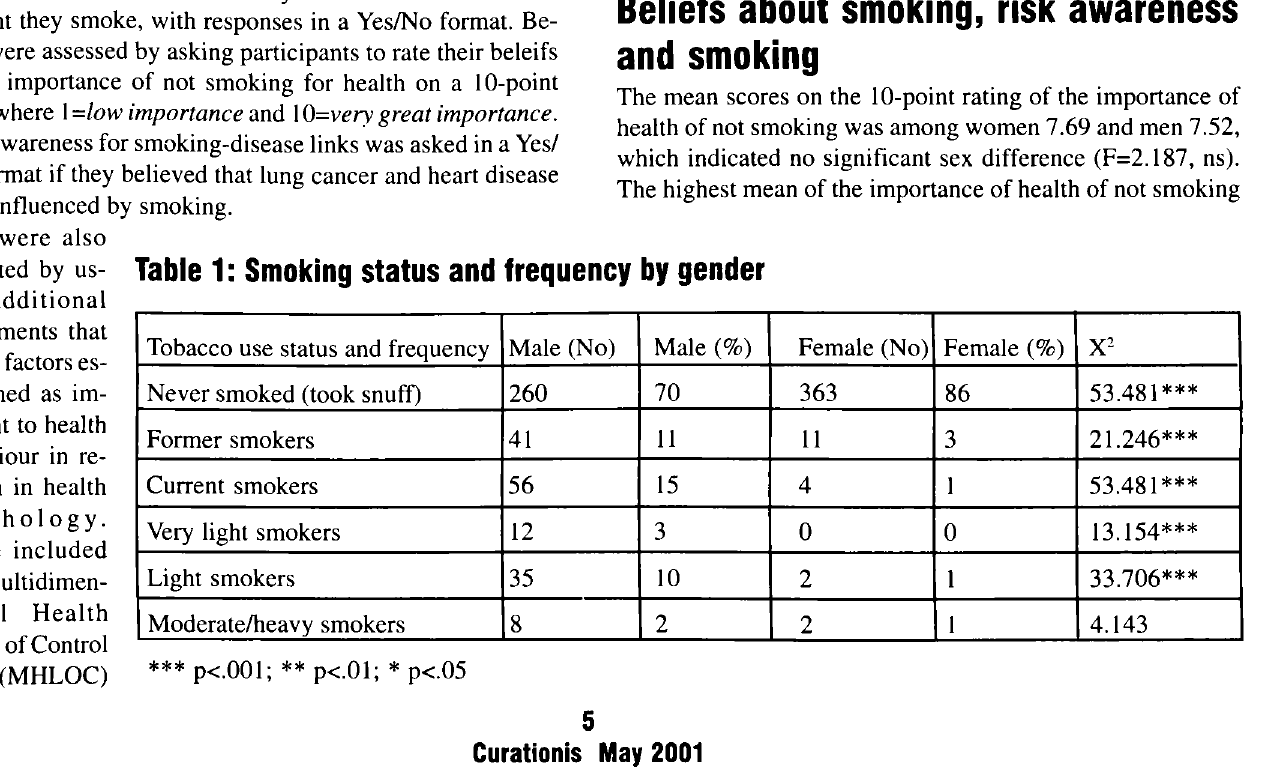
Table 1 : Smoking status and frequency by